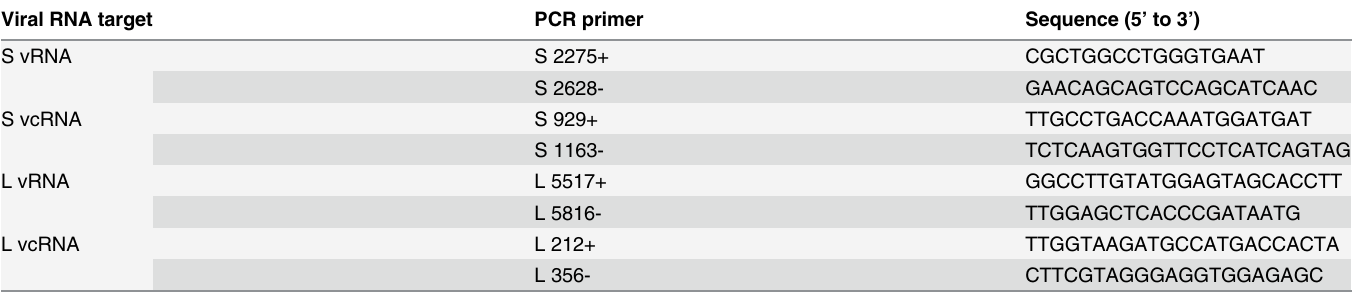
Table 2. Standard RT-PCR primer sets. Viral RNA